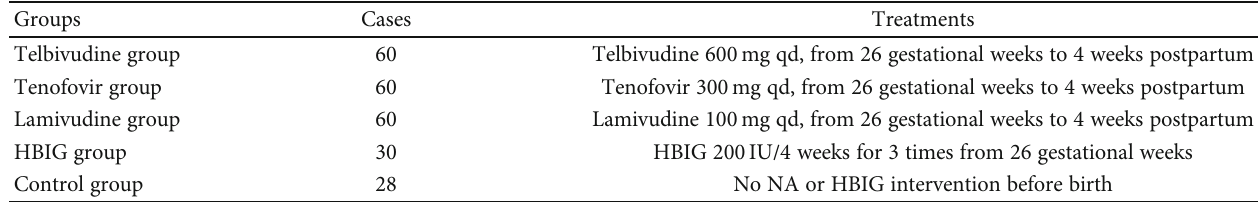
Table 1: Study groups and